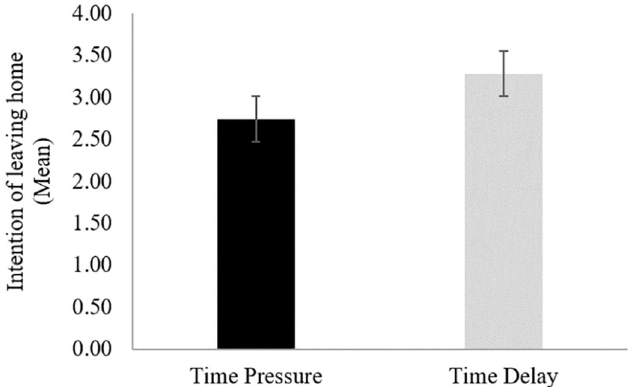
Fig 1. The intention of leaving home for the two types of dual-process manipulation. Error bars represent the standard error of the mean.